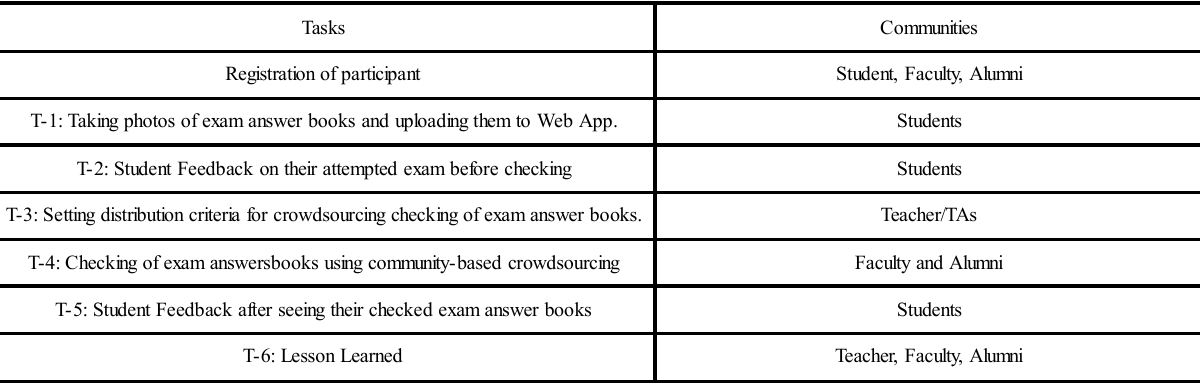
TABLE 1. TASKS IN OUR EXAMCHECK KM